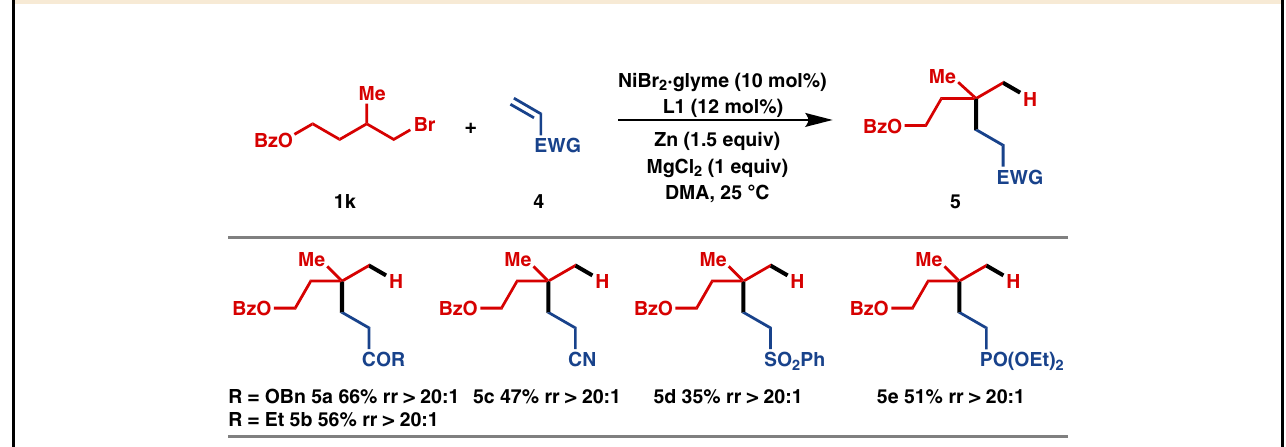
Table 4 Scope of activated alkenes a